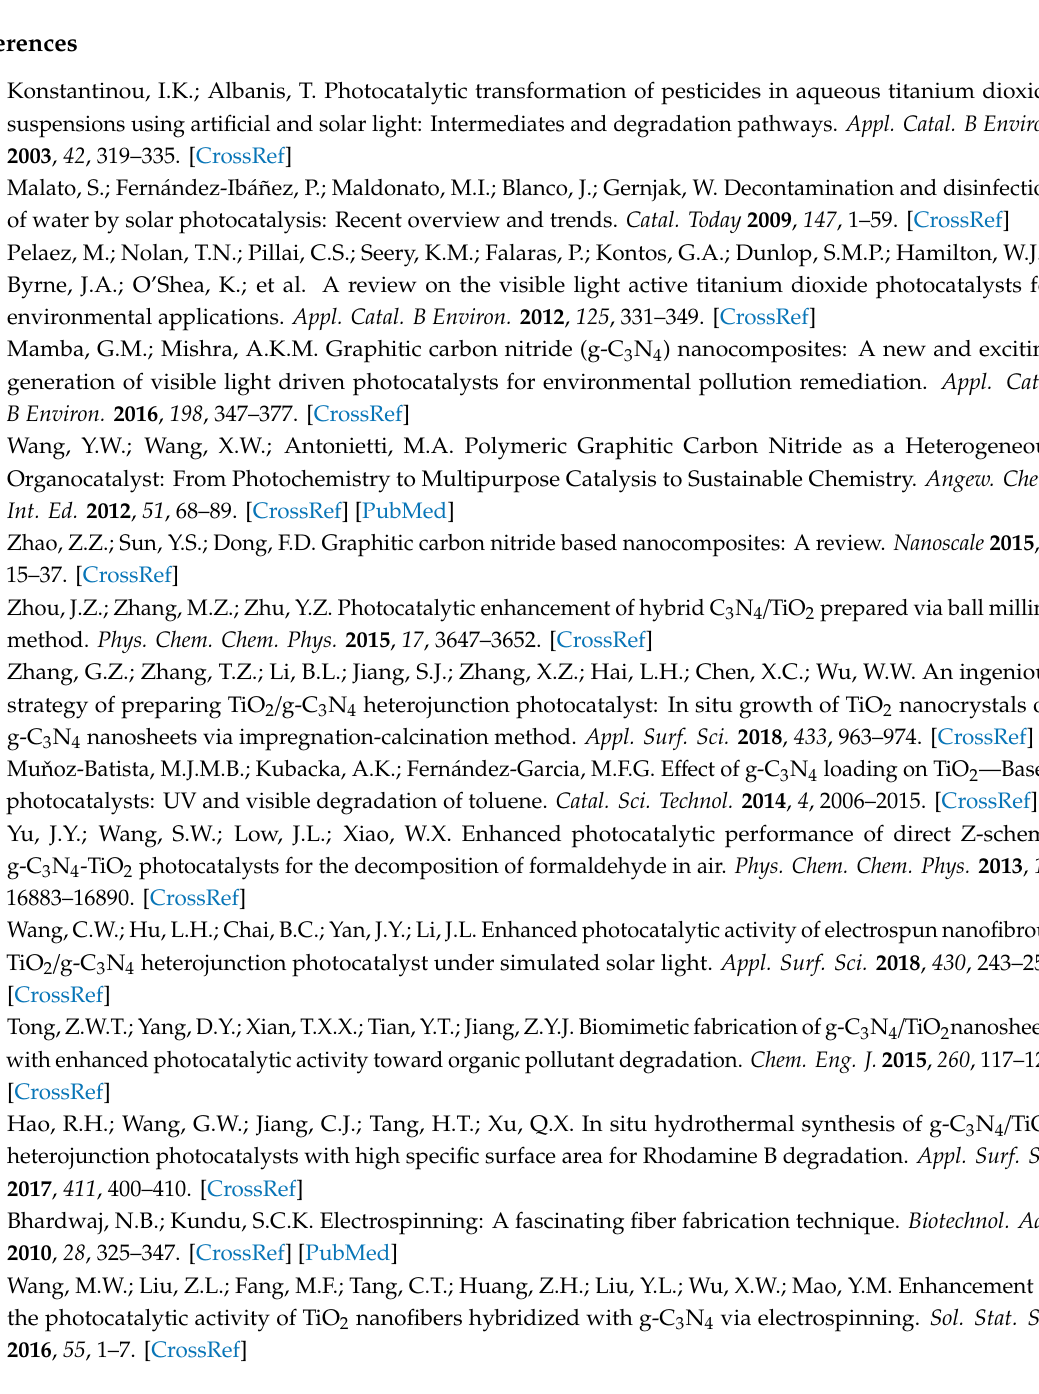
Figure S1: XRD patterns of bulk g-C 3 N 4 ., Figure S2: FT-IR spectrum of PVP fibers, Figure S3: FT-IR spectrum of g-C 3 N 4 , Figure S4: Nitrogen adsorption-desorption isotherms and pore size distributions for g-C 3 N 4 , Figure S5: SEM images of electrospun fibers before calcination (a) TiO 2 , (b) GNT1%, (c) GNT2.5%, (d) GNT5%, Figure S6: SEM images of prepared bulk g-C 3 N 4 , Figure S7: DSC curves of PVP and prepared photocatalyst fibers before calcination, Figure S8: Fluorescence spectra of hydroxyl- terephthalic (OHTA) formation of g-C 3 N 4